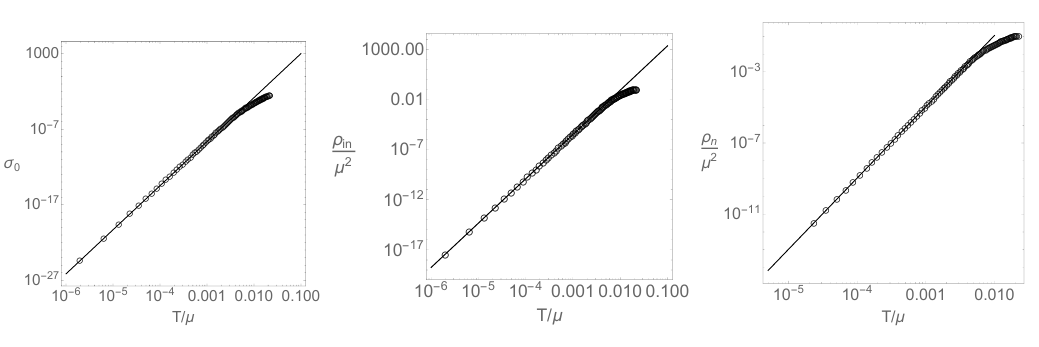
+ # T 3 , ρ n ∼ ρ (0) n + # T 7 3 . in